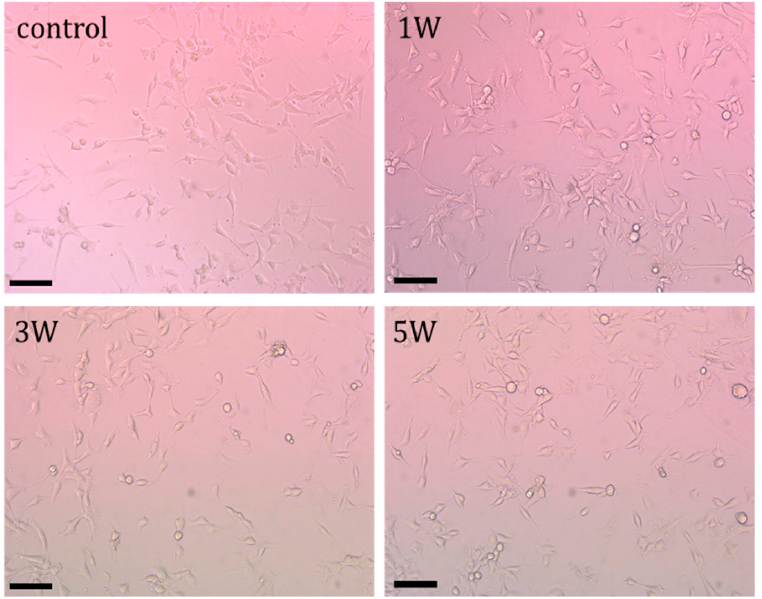
Figure 6. Optical microscopy images of cells 24 h post-irradiation with 808 nm laser for 10 min ( P = 0, 1, 3 and 5 W/cm 2 ). Scale bar 100 μ m.